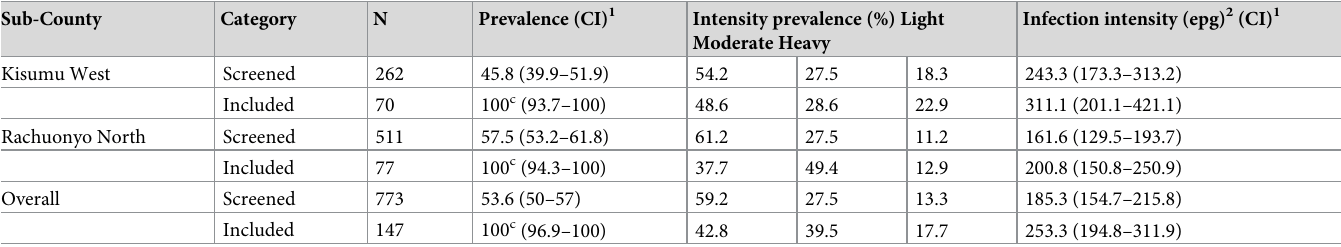
Table 2. Prevalence and intensity of Schistosoma mansoni infection in included and non-included women of reproductive age in Kisumu West and Rachuonyo North sub-Counties.